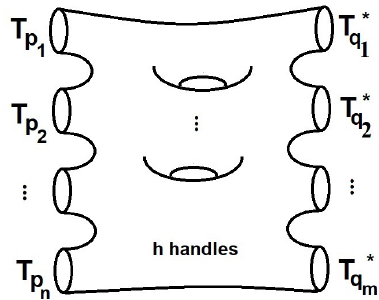
Figure 1 . Genus h − 1 surface with insertions of elements of the class algebra. A surface with h = 2 is